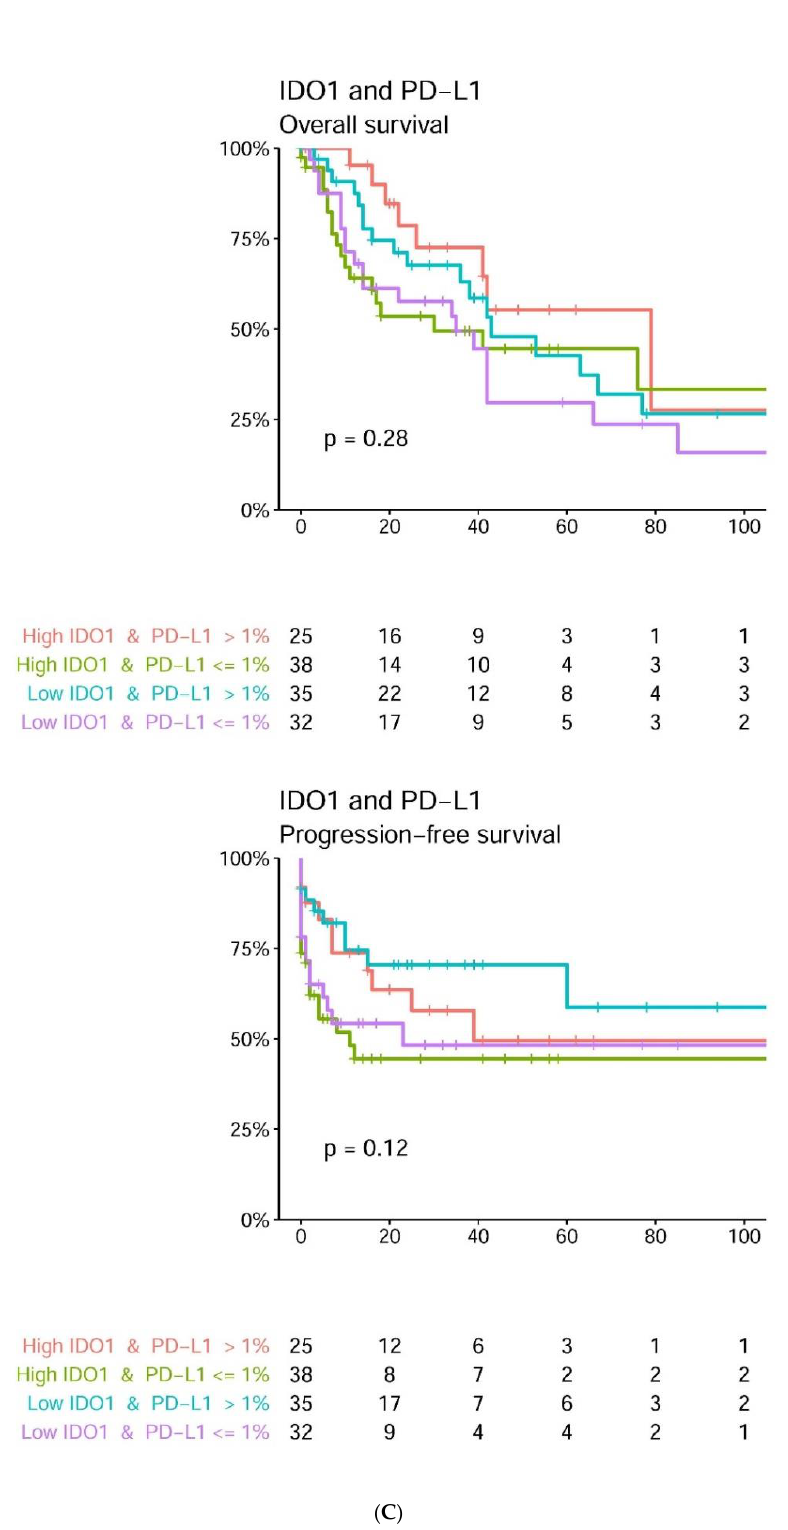
Figure 3. ( A ) Kaplan–Meier curves illustrate the associations between tumoral PD-L1 expression and intratumoral FoxP3+ cell count for overall survival and progression-free survival. ( B ) Kaplan–Meier curves illustrate the associations between tumoral PD-L1 expression and intratumoral CD8+ cell count for overall survival and progression-free survival. ( C ) Kaplan–Meier curves illustrate the associations between tumoral PD-L1 expression and tumoral IDO1 expression for overall survival and progression-free survival.